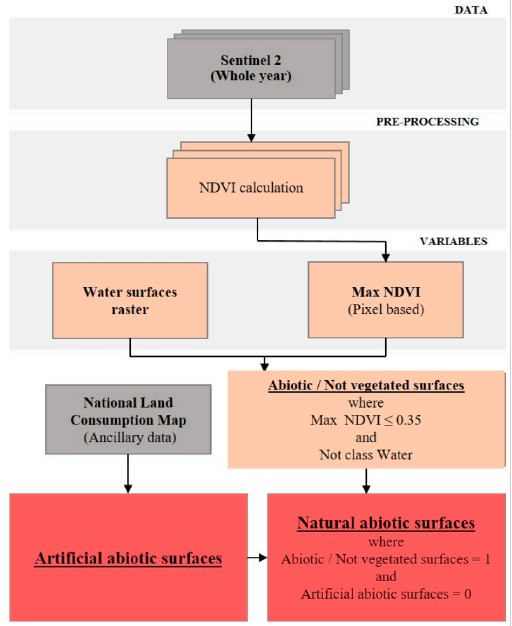
Figure A2. Workflow for abiotic surfaces